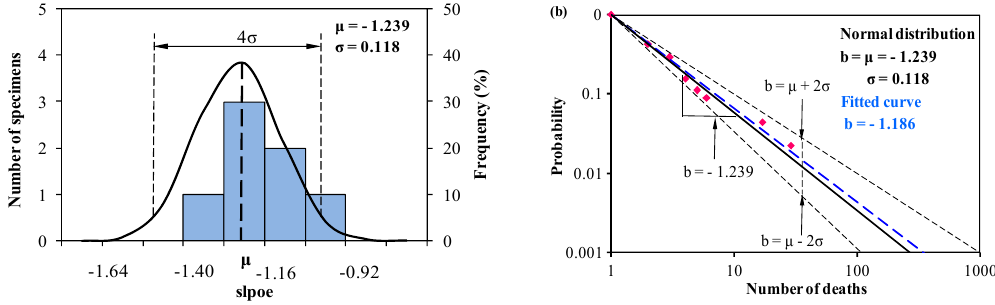
Figure 6. ( a ) Normal distribution analysis of the slope b i determining the relation between the accumulated frequency and number of deaths, and ( b ) predictions from Equation (1) and Equation (3) based on the normal distribution analysis of b i in ( a ) together with the statistical data from 2000 to 2008 in China digitized from Yang et al. [12].